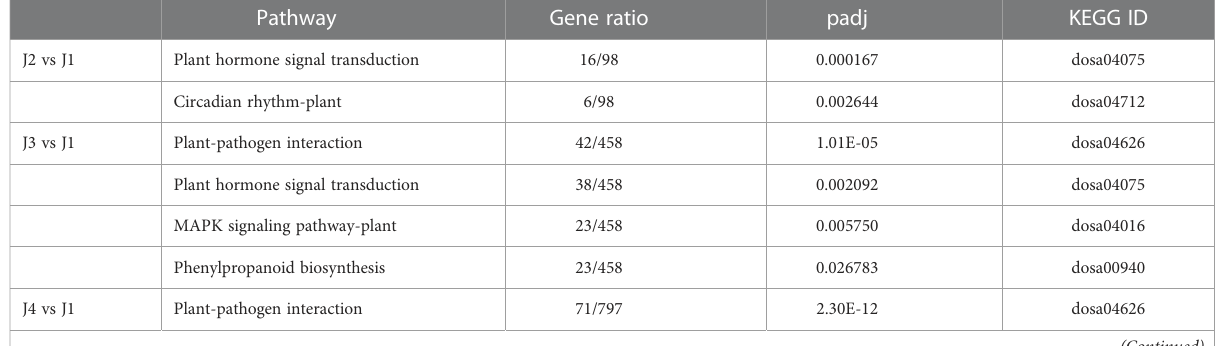
The GO and KEGG enrichment analyses of the DEGs both highlighted that the plant hormone signal transduction pathway (dosa04075) was particularly affected by the freezing treatment (Figure 3; Table 2). Among the 1240 DEGs shared by all time points, many genes encoding a protein kinase and probably involved in the signal transduction were detected (Supplemental Table S2). More than 40 genes predicted to encode a protein kinase were differentially expressed under freezing treatment. Most of the genes were up regulated while only 6 genes were down regulated by TABLE 2 Signi fi cantly enriched gene pathways at each time point following the low temperature treatment. Pathway Gene ratio padj KEGG ID J2 vs